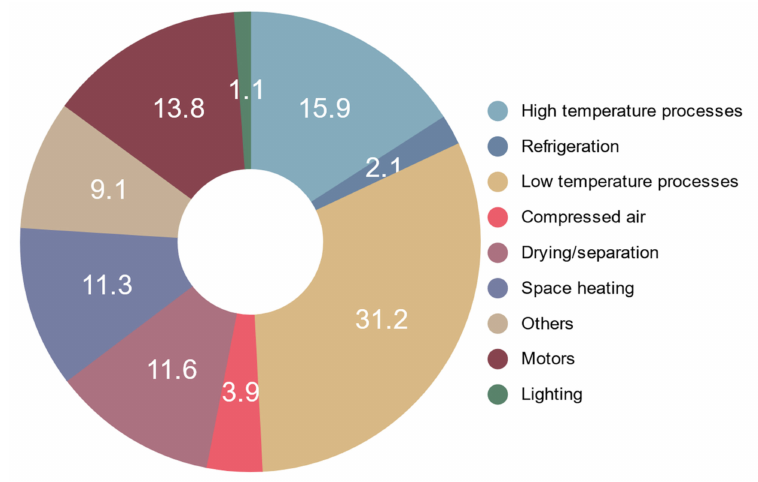
Figure 1. The percentage share of waste heat energy by different industries in United Kingdom